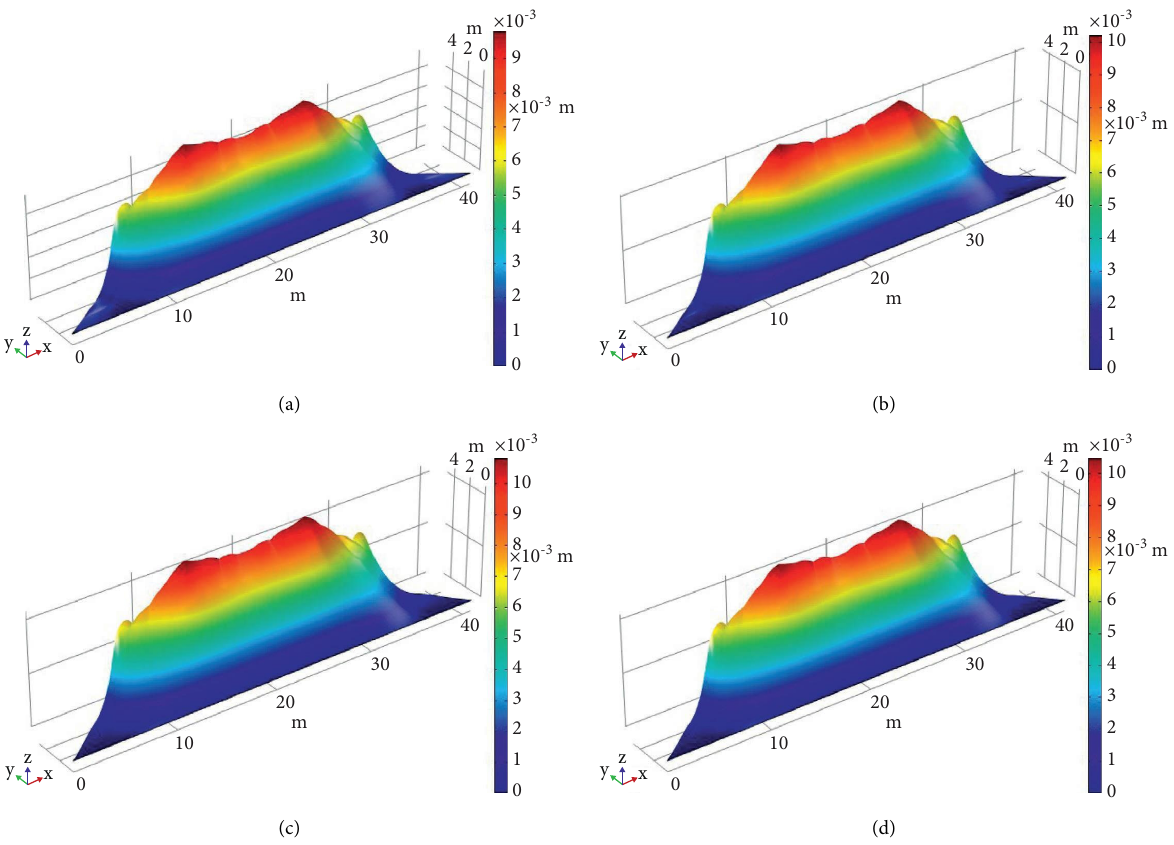
Figure 11: Schematic diagram of the height change of the cross-section of the reinforced Earth embankment: (a) d � 1; (b) d � 3; (c) d � 5; (d) d �